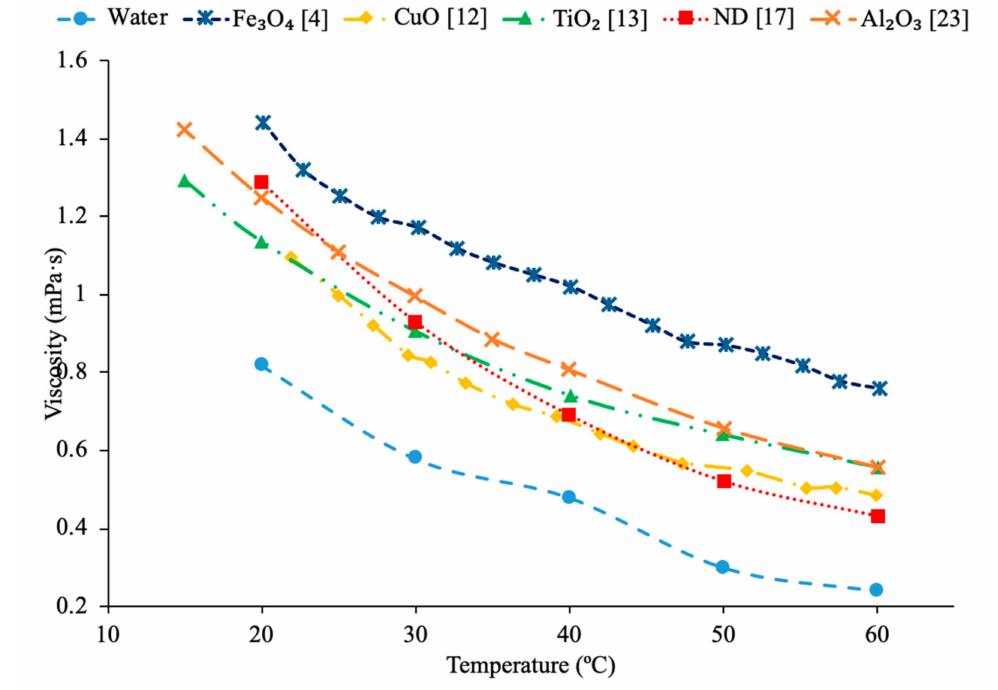
Figure 30. Viscosity of Al 2 O 3 , TiO 2 , ND, Fe 3 O 4 and CuO water-based nanofluids at a volume fraction of 1% as a function of temperature